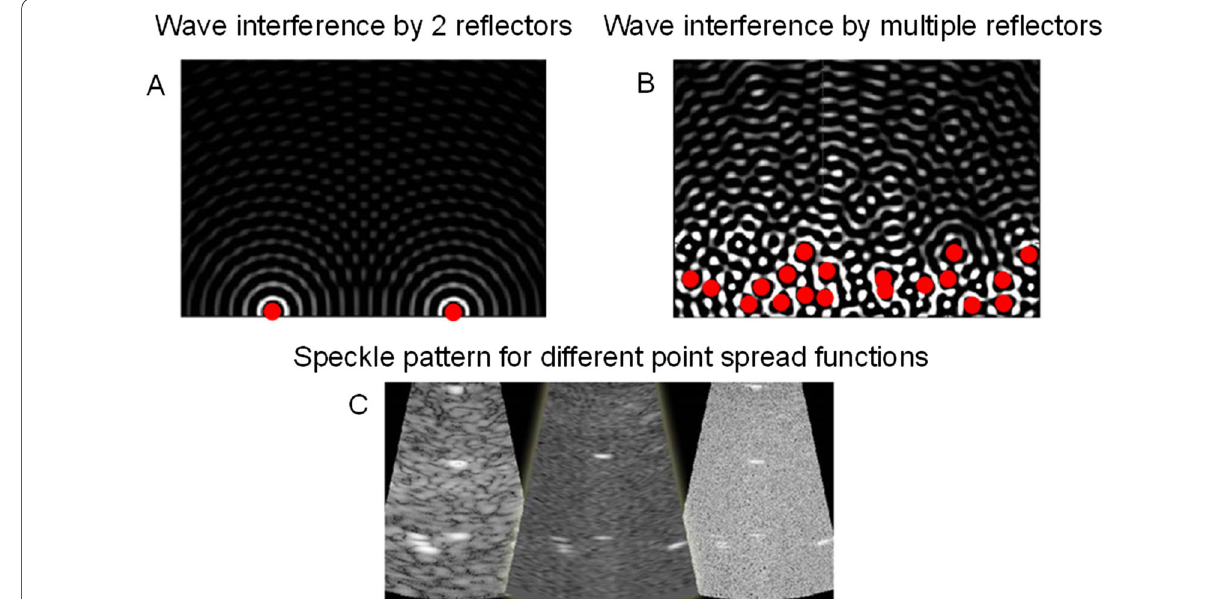
Fig. 5 a Constructive and destructive wave interference patterns when forward echoes sent by a transducer (on the top of the image) are reflected or scattered by 2 particles located at the same depth. b Wave interference patterns when reflectors or scatterers are distributed in space. c B-mode images with different speckle patterns obtained from same reflectors or scatterers distributed in space, but with different point spread functions at lower to higher frequencies from left to right. The terminology “reflector” is generic here but formally a reflector has a dimension larger than the acoustic wavelength, whereas a scatterer has a dimension much smaller than the wavelength